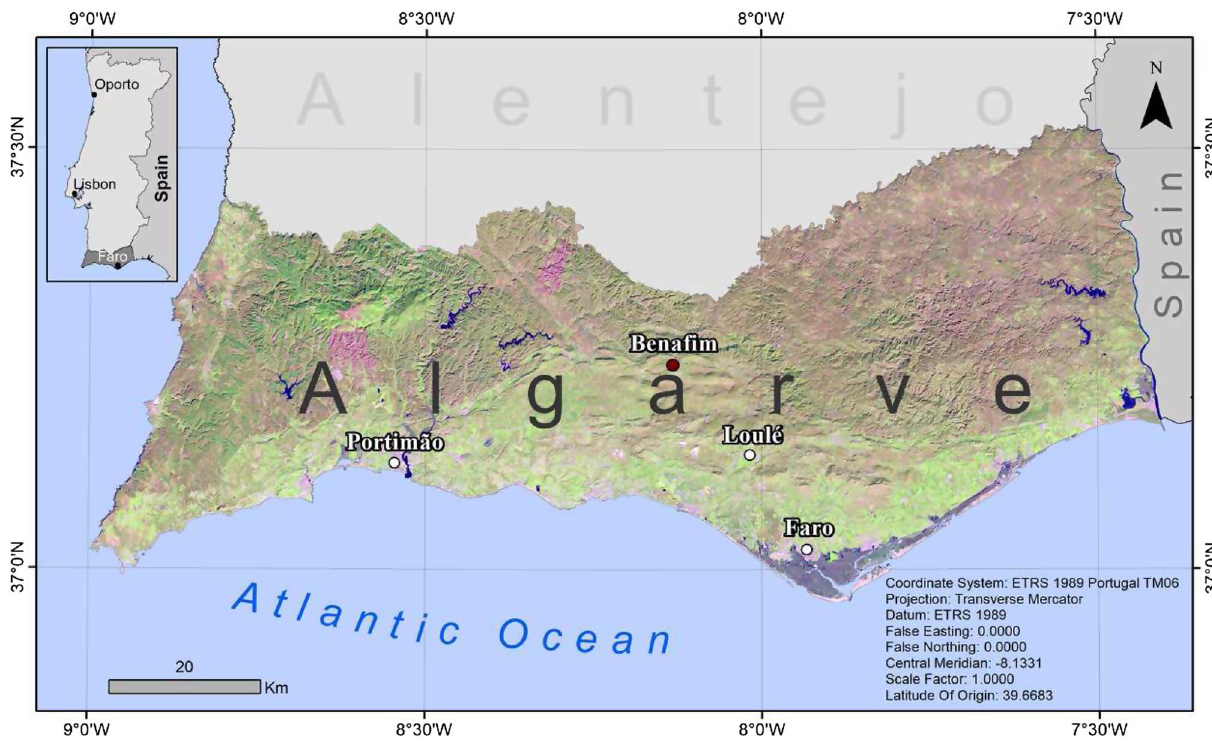
Figure 1. Algarve (Landsat 8 image: US Geological Survey